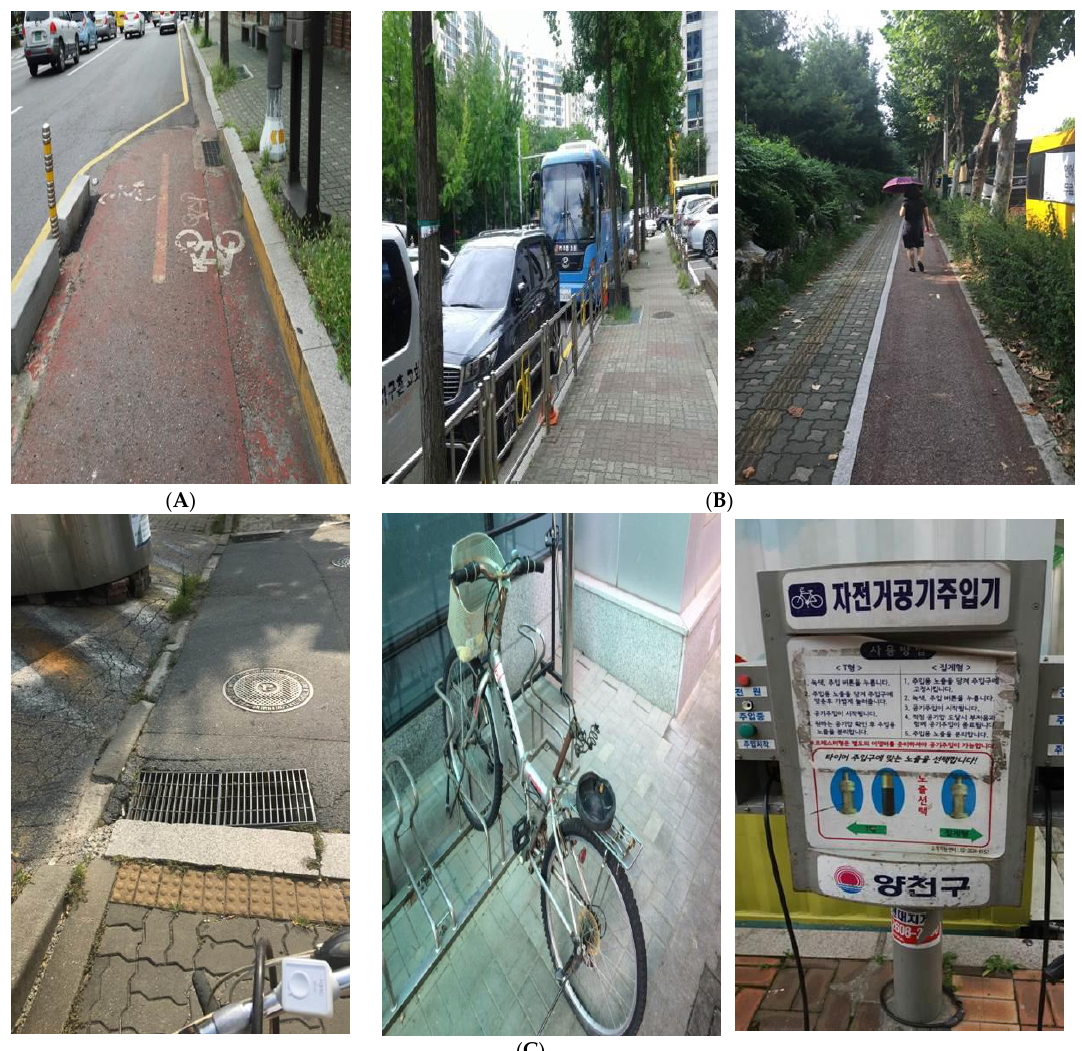
Figure 3. Factors that hinder bikeability. ( A ) “Bicycle-friendly” physical environment—Disconnection of cycle tracks. ( B ) Conflicts over bicycle use: (left)—Illegal parking; (right)—Pedestrian walking on bikeway. ( C ) Supportive community system: (left)—Poor management of road; (center)—A bicycle with a saddle stolen; (right)—Bicycle management equipment with insufficient instruction.